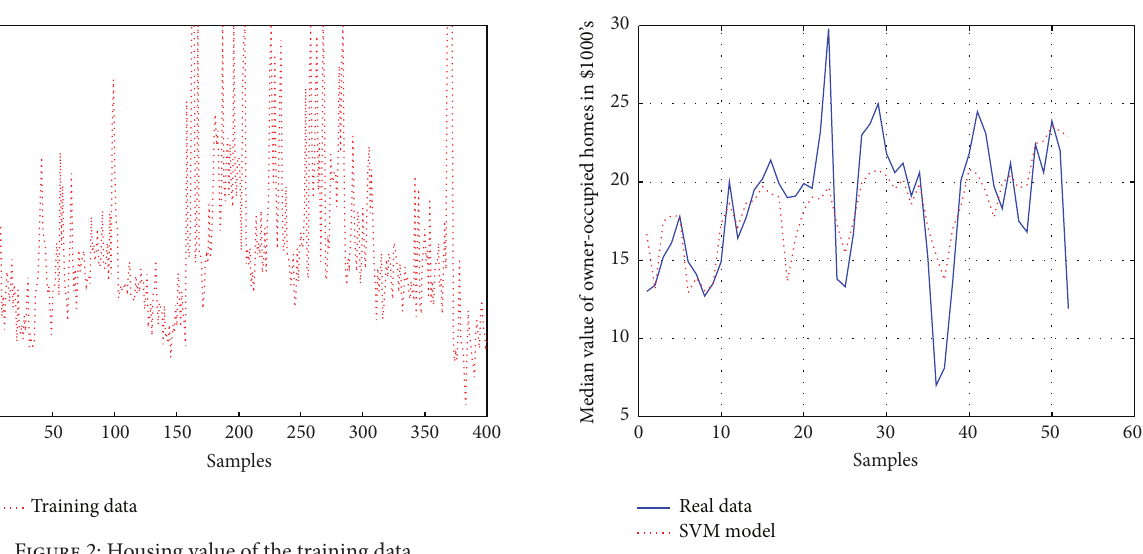
Figure 3: Forecasting results by SVM.